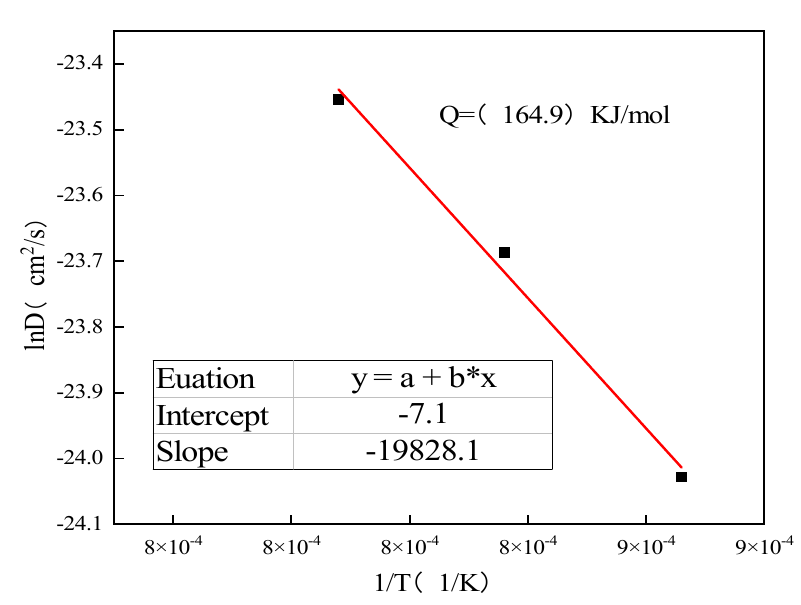
Figure 11. Square of vanadiumizing layer thickness versus duration at different temperatures.